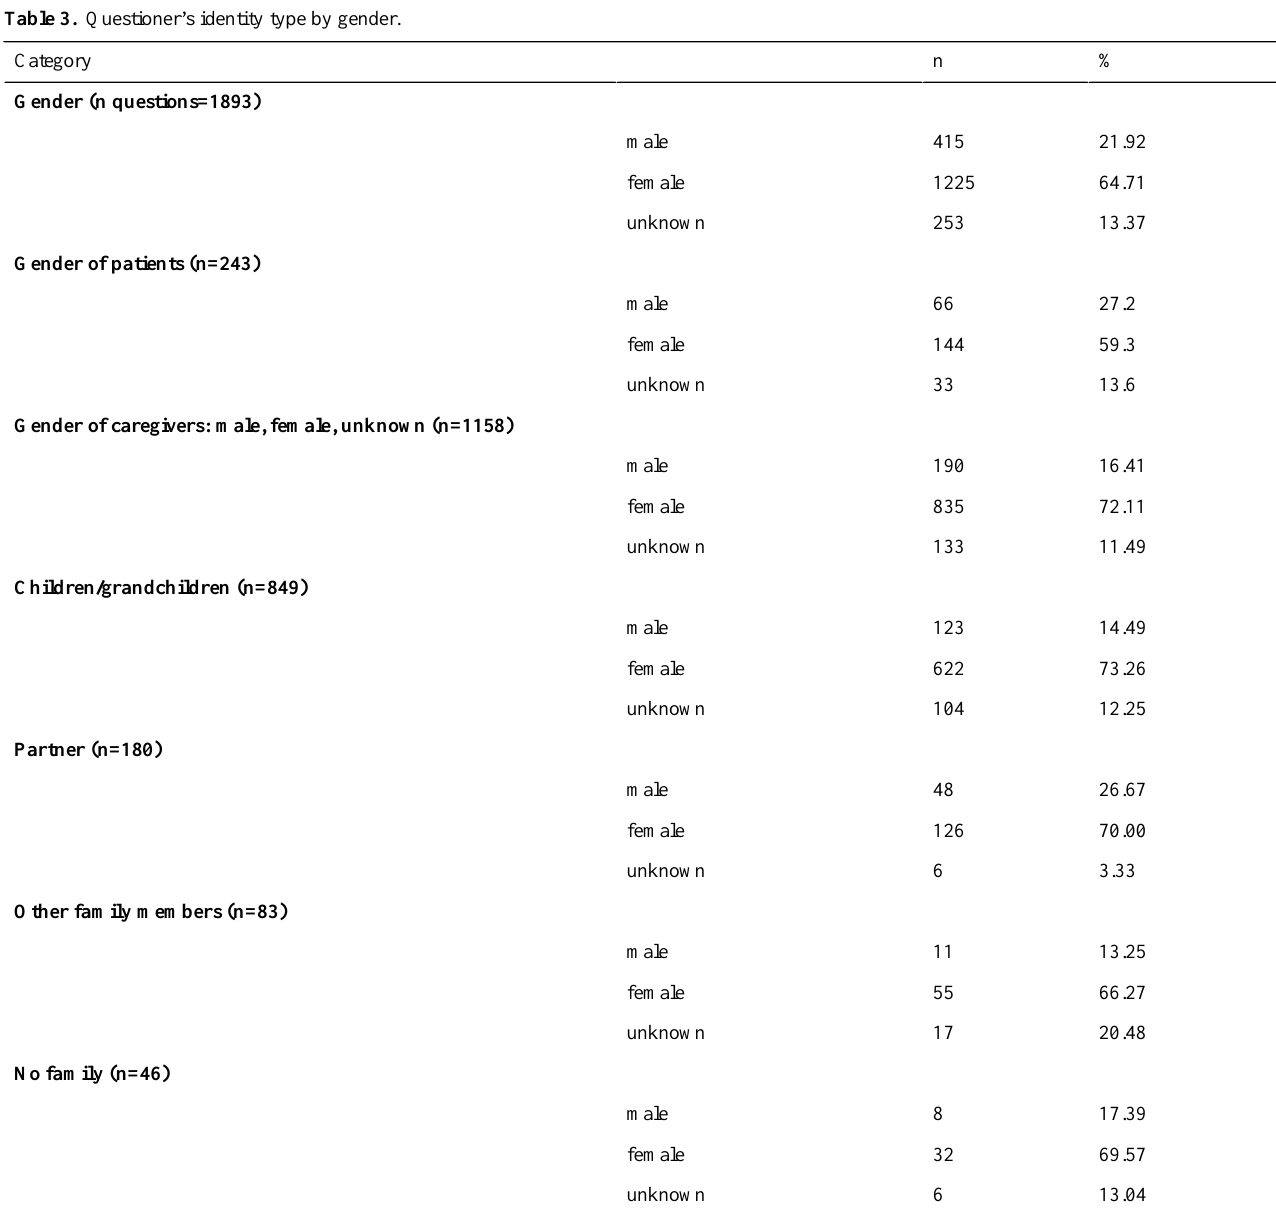
Table 3. Questioner’s identity type by